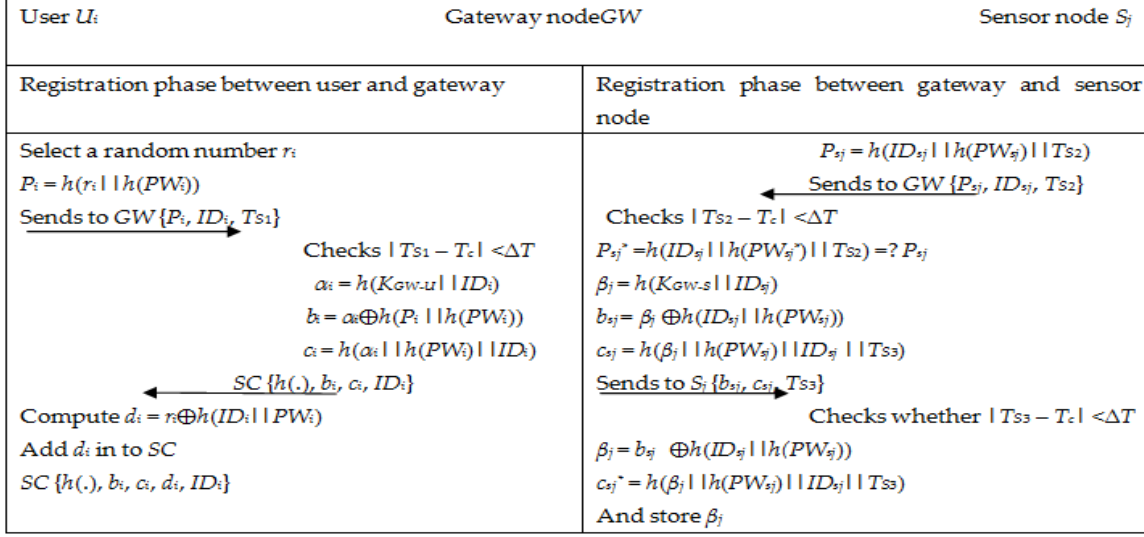
Figure 2. Registration phase of Singh et al.’s scheme.